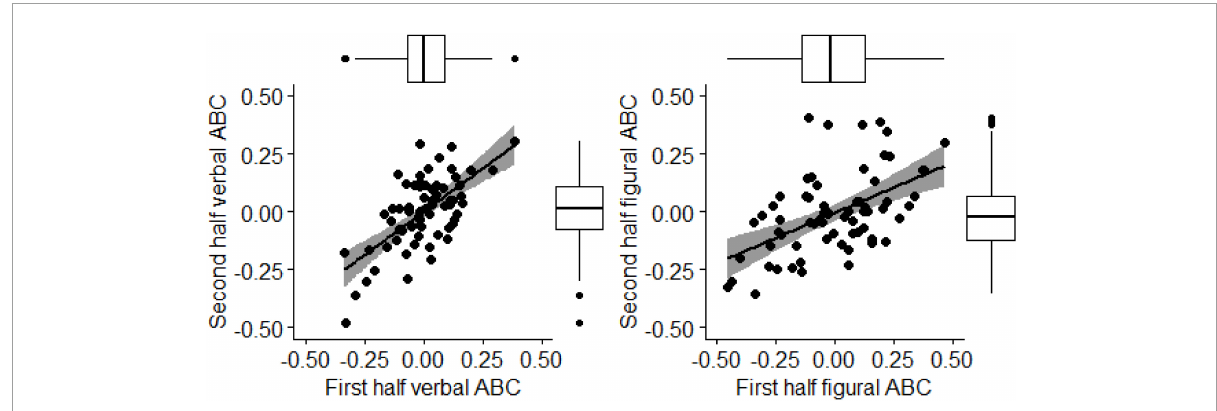
FIGURE1 Scatter plot of first and second half performance (i.e., split-half stability) for the verbal (left) and the figural ABC (right) . Slope and corresponding credibility intervals are depicted.